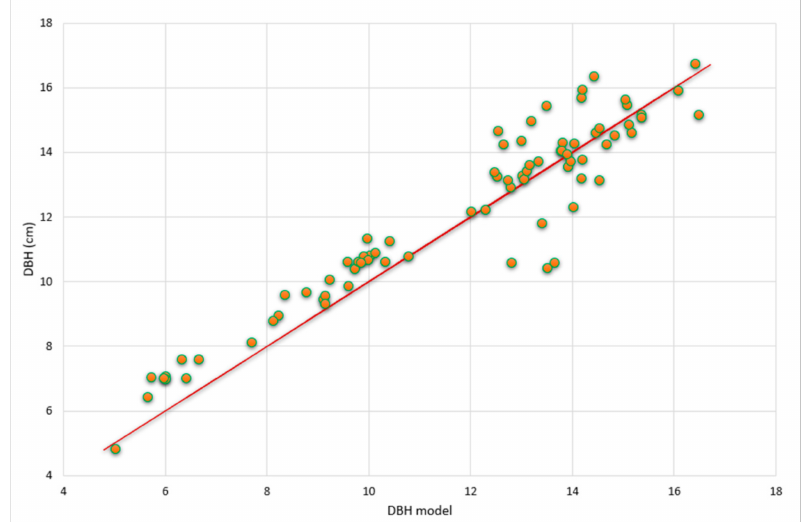
Figure 6. Measured dbh values vs. model predictions for the validation data. The coe ffi cient of variation value is R 2 =